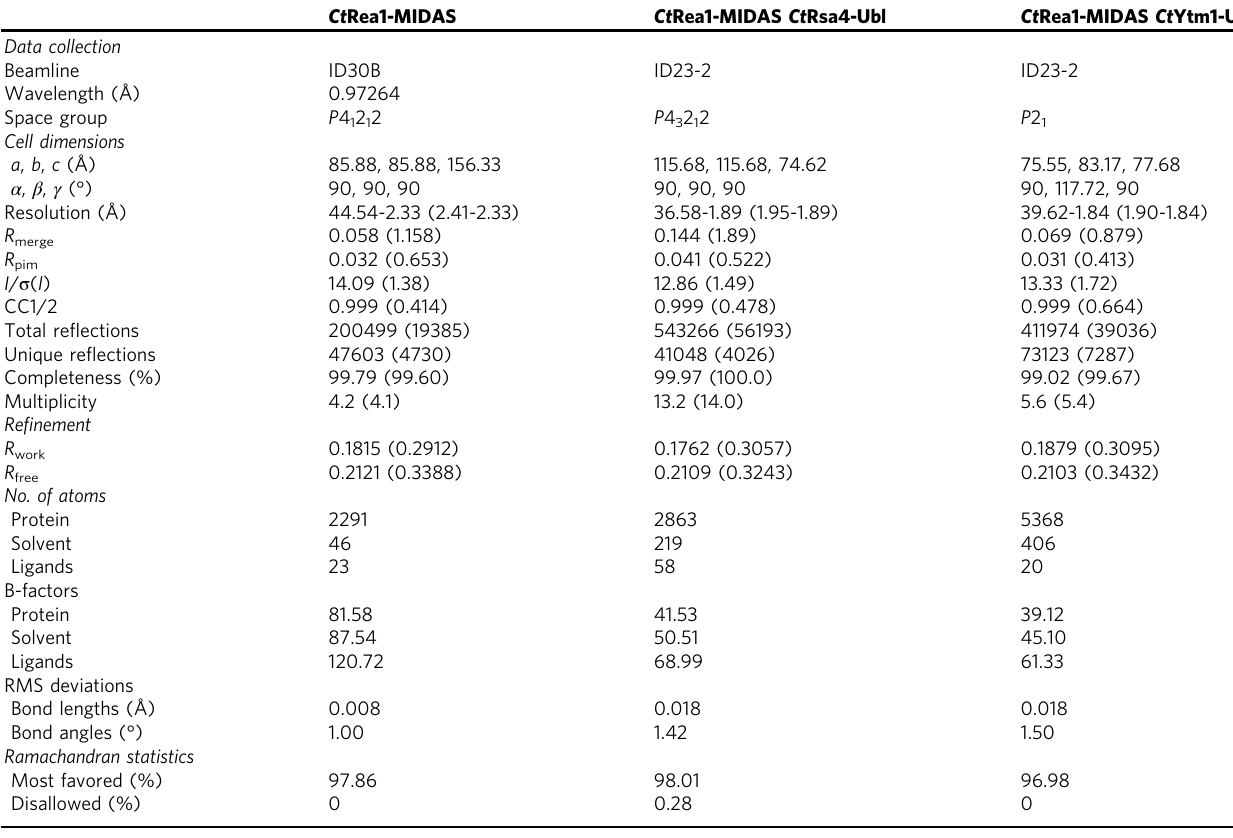
Table 1 Data collection and re fi nement